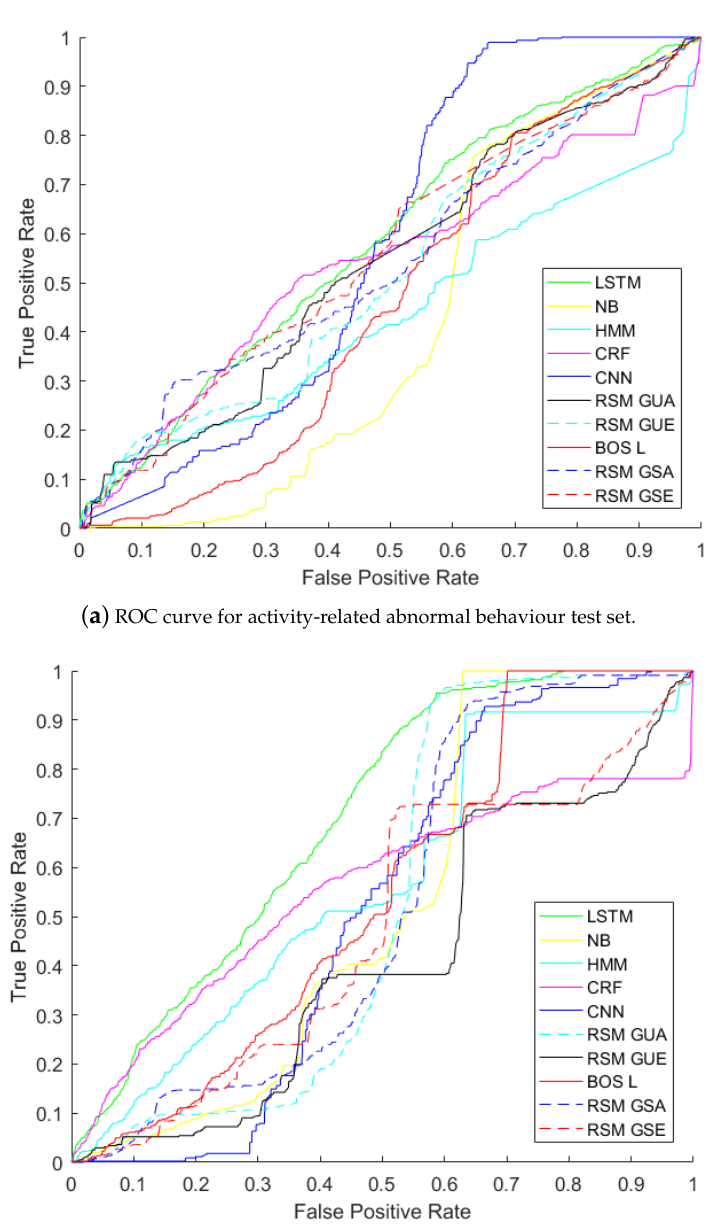
Figure 6. ROC curves for abnormal behaviour detection with both activity-related and sub-activity- related abnormal